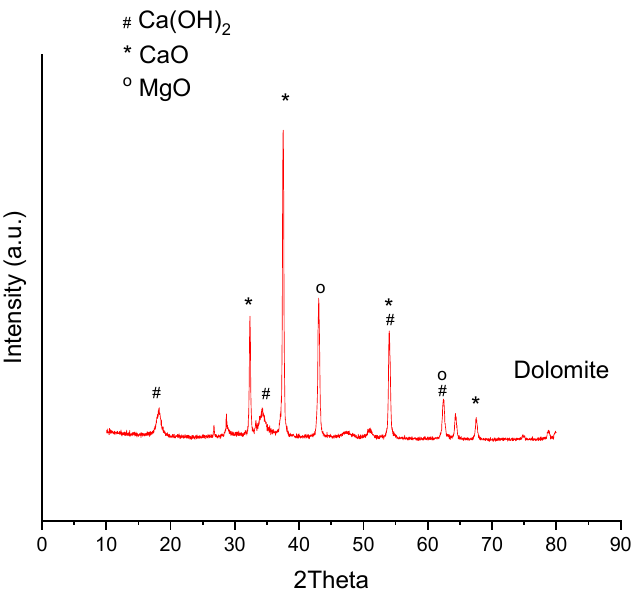
Figure 11. XRD patterns of calcined dolomite.